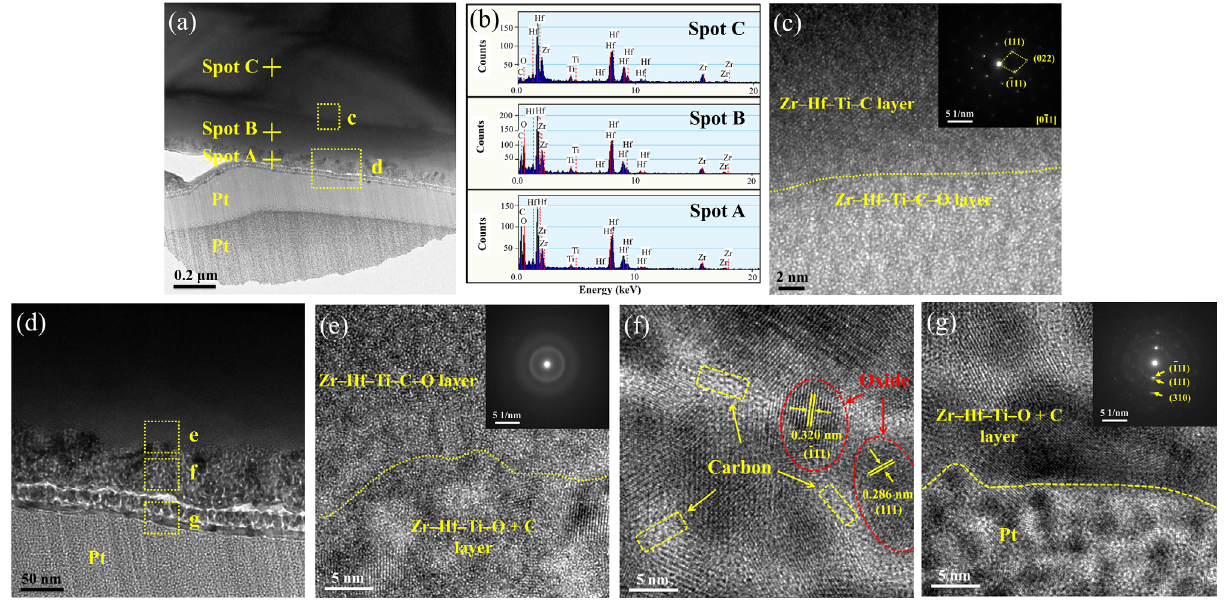
Fig. 8 TEM observations of Zr 0.3 Hf 0.5 Ti 0.2 C 0.8 after being oxidized at 500 ℃ for 1 h in air: (a) TEM image, (b) EDS analysis of Spots A, B, and C in (a), (c) high resolution TEM (HRTEM) image of Zone c in (a), (d) enlargement of zone d in (a), and (e–g) HRTEM images of zones e–g in (d), respectively. The insets of (c, e, and g) are the corresponding SAED